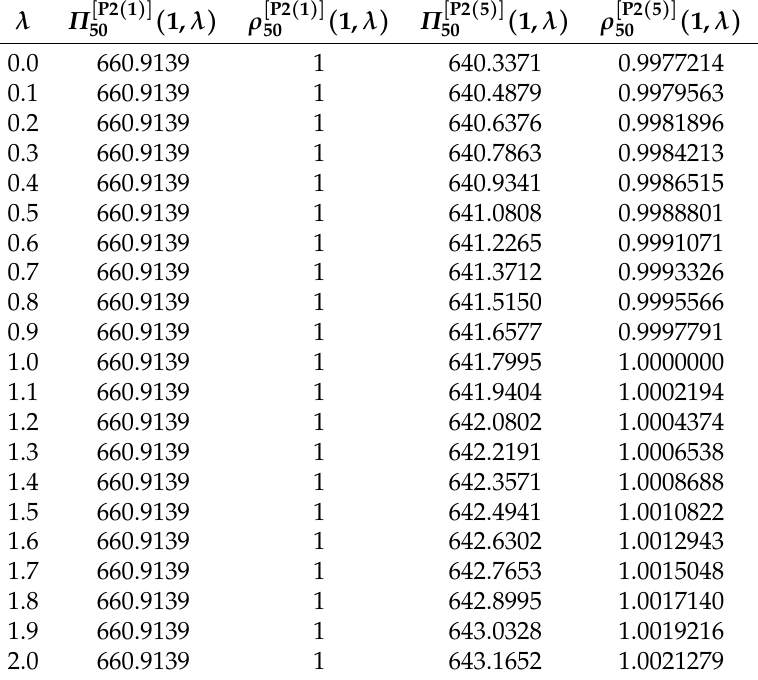
Table 14. Product P2 (acceleration benefit); x = 50, C =